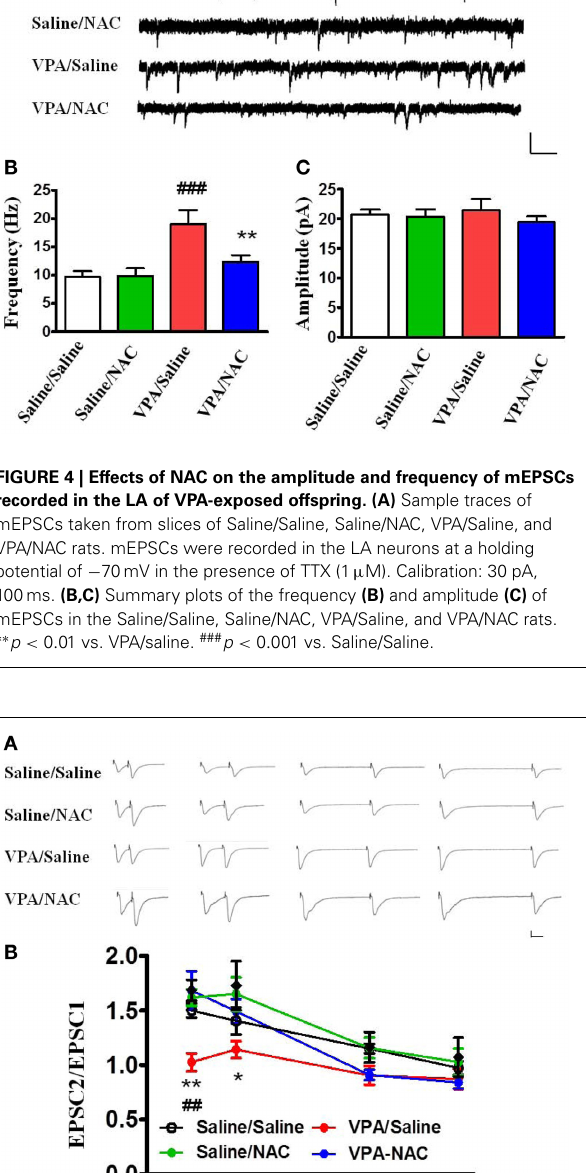
thalamo-LA synapses from brain slices of VPA-exposed offspring.